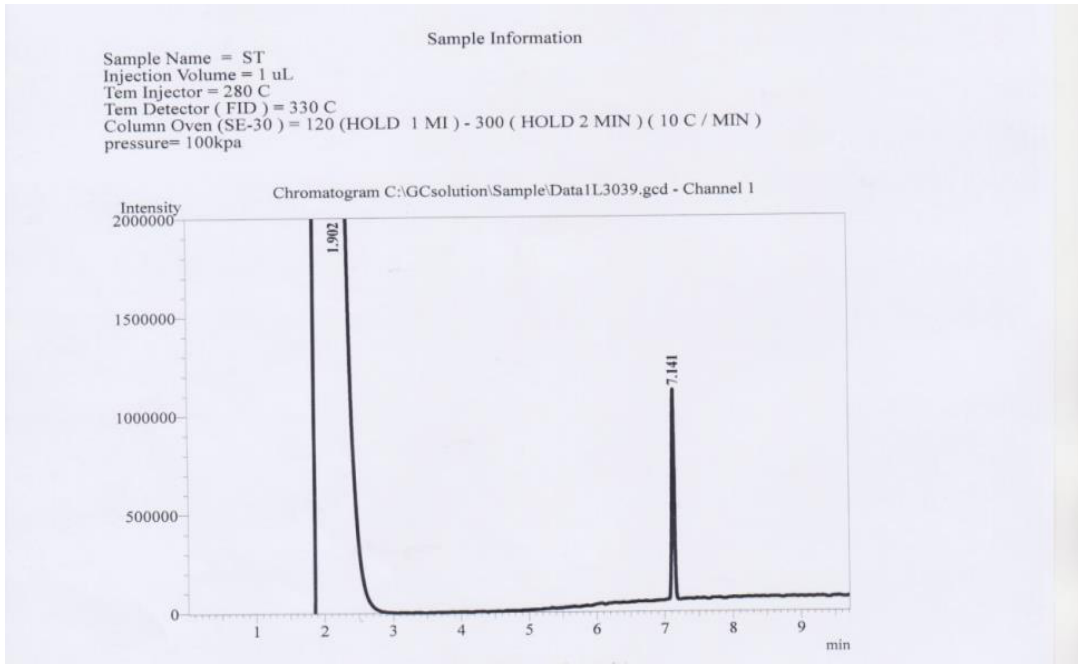
Figure 10. HPLC chromatogram of mirtazapine pure powder